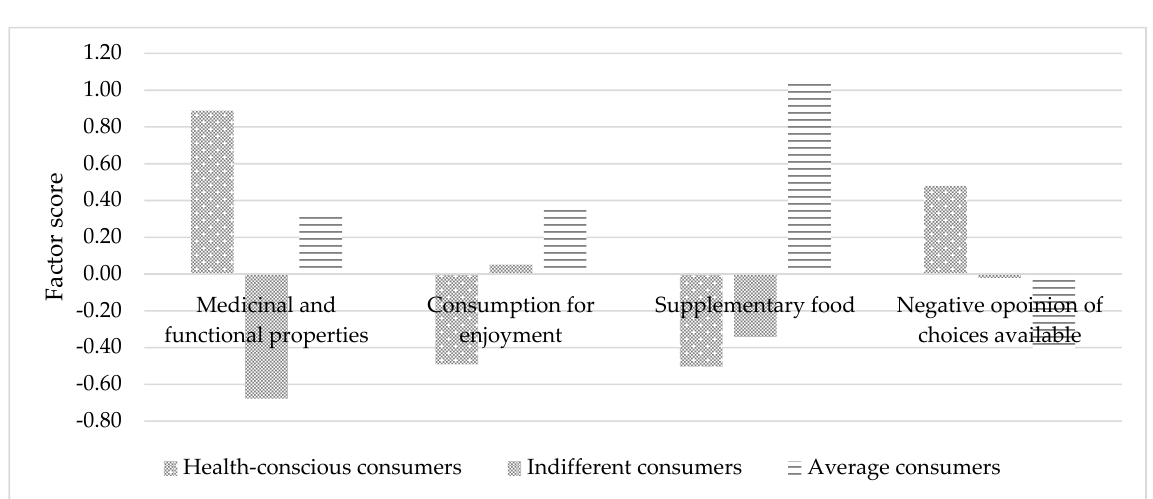
Figure 4. Characteristics of the clusters generated based on level of consciousness in consumption. Based on the results of the Chi-square test (Chi 2 = 49.48, p <0.001), a significant corre-